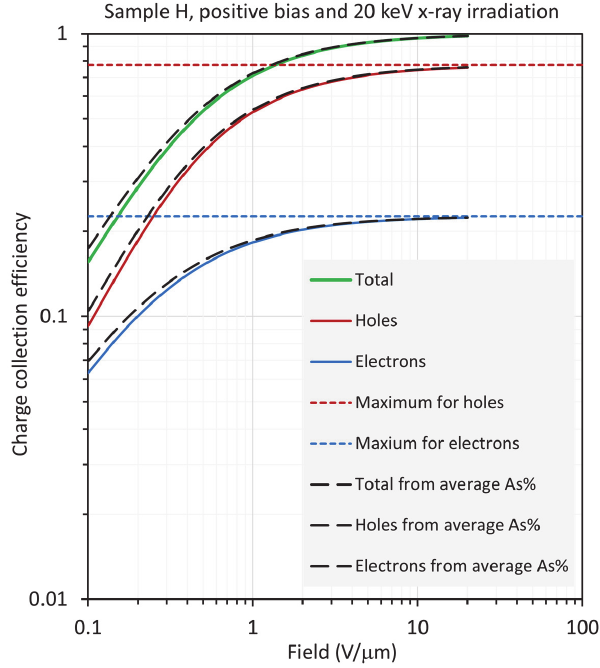
Figure 8. Log–log plot of the CE as a function of field for sample H (near optimum), biased positively and exposed to X-rays with a photon energy of 20 keV, so that δ / L =0.243.